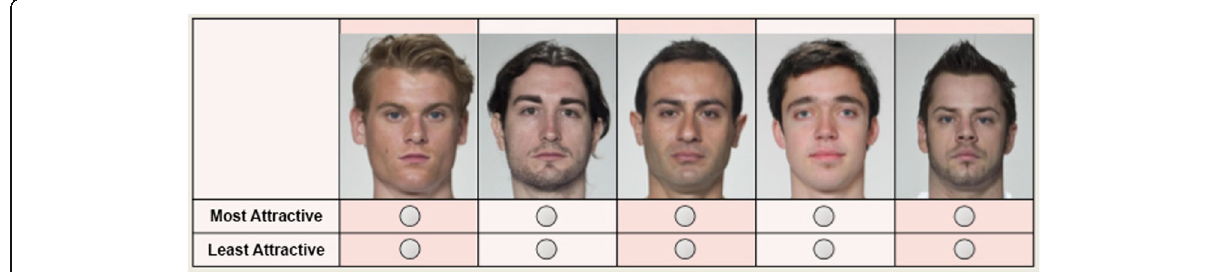
Fig. 1 An example of a best-worst scaling (BWS) trial. Participants view a subset of the faces to be rated, and select the “ best ” (in this case, most attractive) and “ worst ” (in this case, least attractive) from the subset. This “ best ” / “ worst ” decision is easy to understand, naturalistic and relies only on the faces presented in the current trial, with no need to remember previous responses. These faces, from the Face Research Lab London Set (DeBruine & Jones, 2017), are for illustration purposes only, and were not used in the studies reported